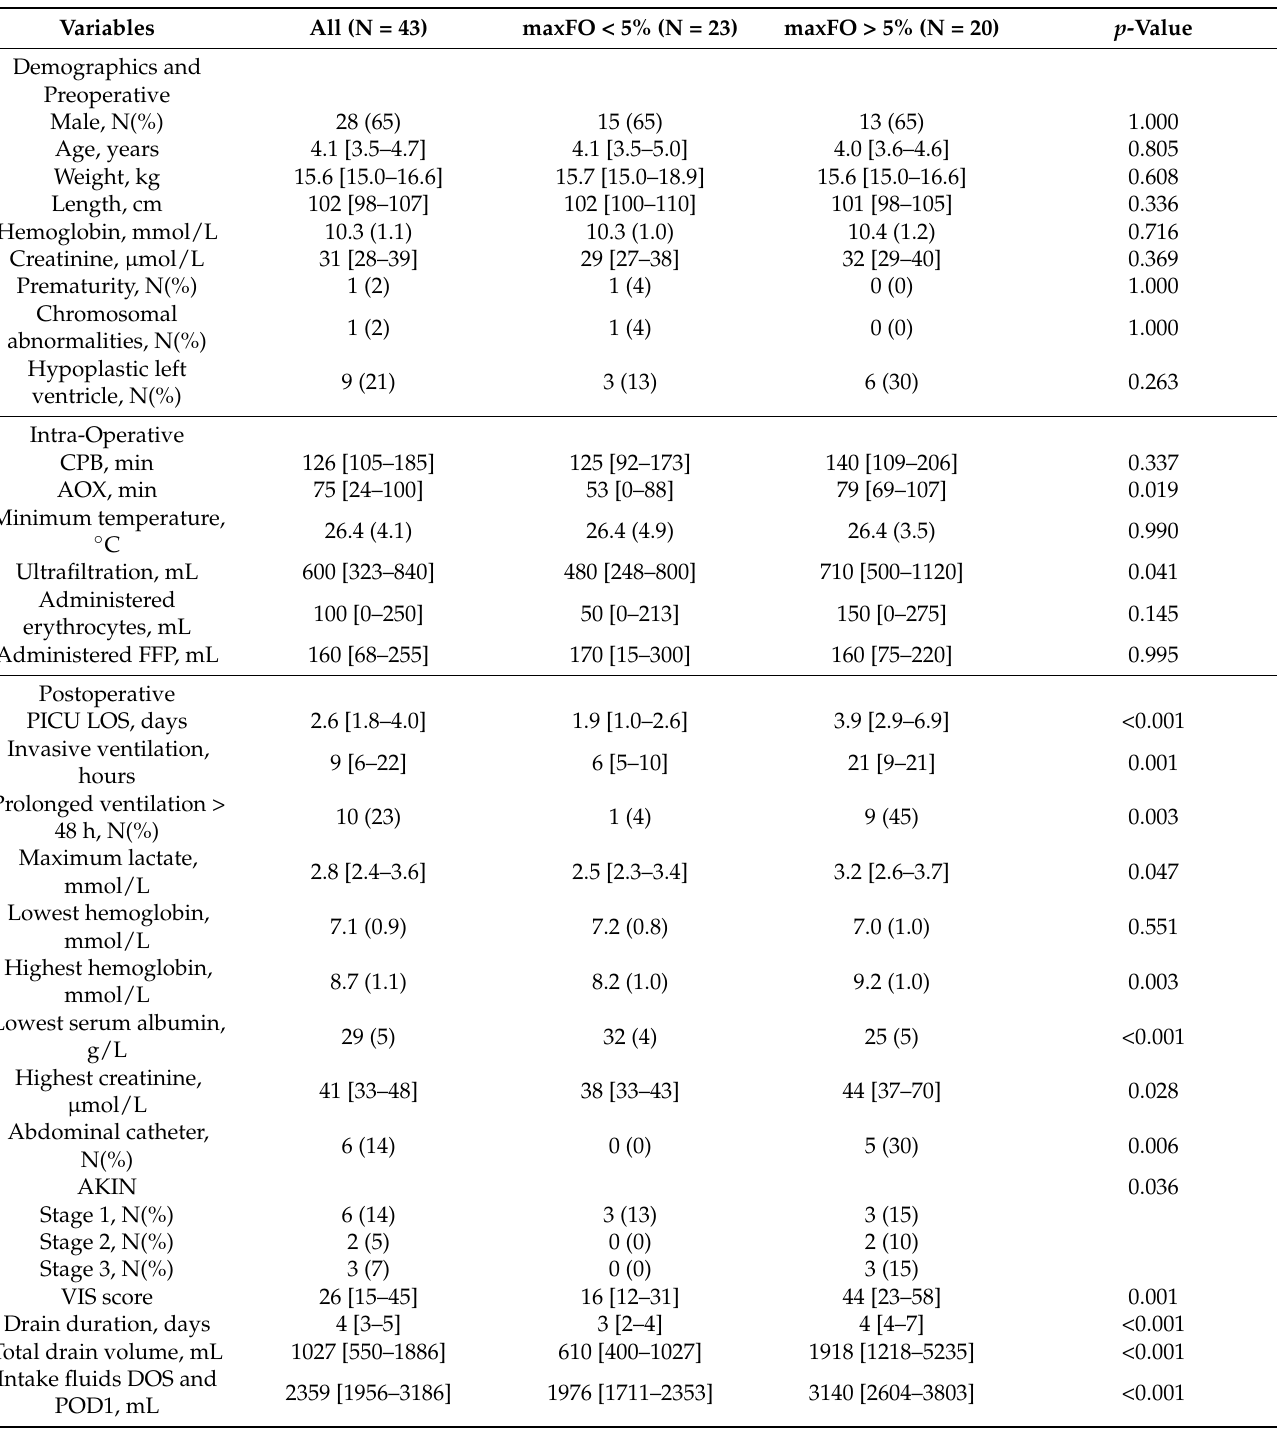
Table 1. Demographics, preoperative, intra-operative and postoperative parameters by maximum percentage of fluid